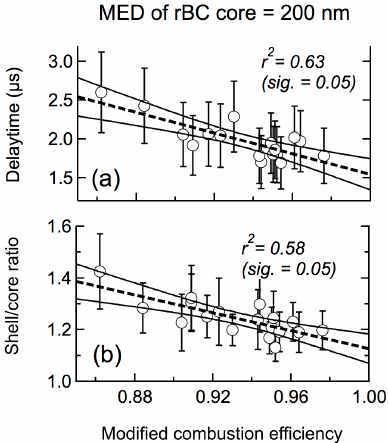
Figure 5. Variations in the delay time (a) and the shell/core ratio (b) as a function of MCE values for rBC particles with MED = 200 ±